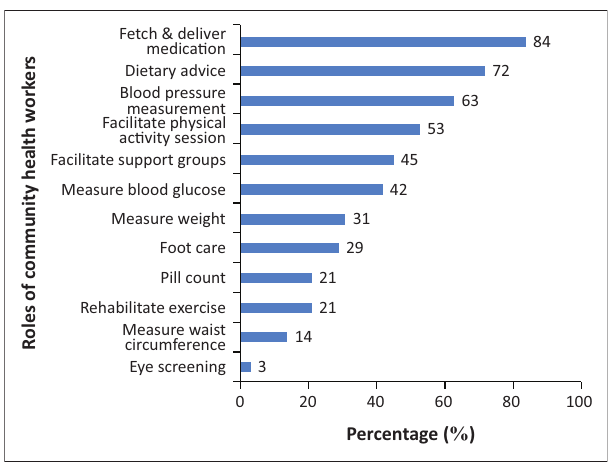
FIGURE 1: Non-communicable disease-related roles or tasks performed in the community ( n = 150).